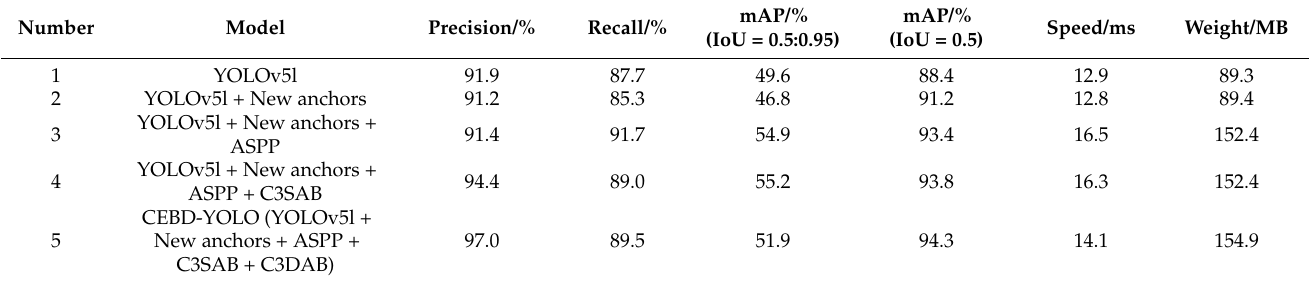
Table 5. The experimental results of different optimization modules’ ablation comparisons.